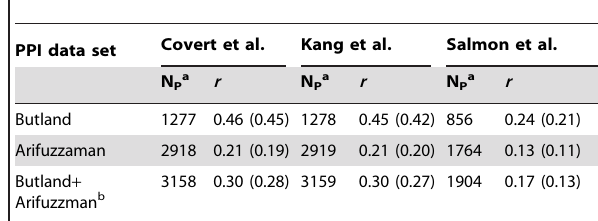
Table 2. Pearson and Spearman rank (in parentheses) correlation coefficients ( r ) for tests of linear association between log(degree) and log 2 (mRNA expression) in raw E. coli TAP PPI data